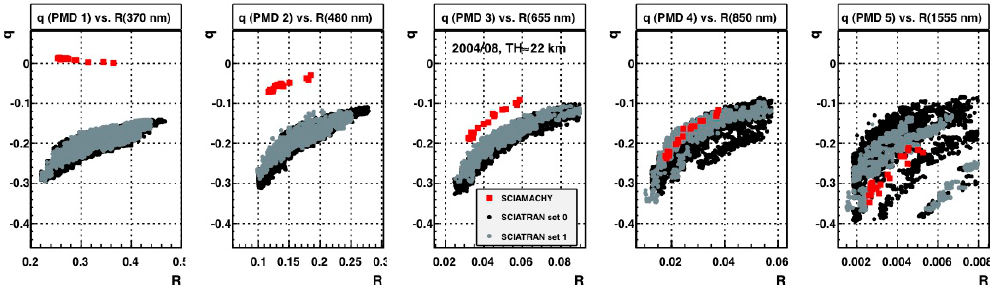
Fig. 4. Correlation between polarization q and reflectance R , for the same data as in Fig. 2 (August 2004, reference state 20, TH ≈ 22km).